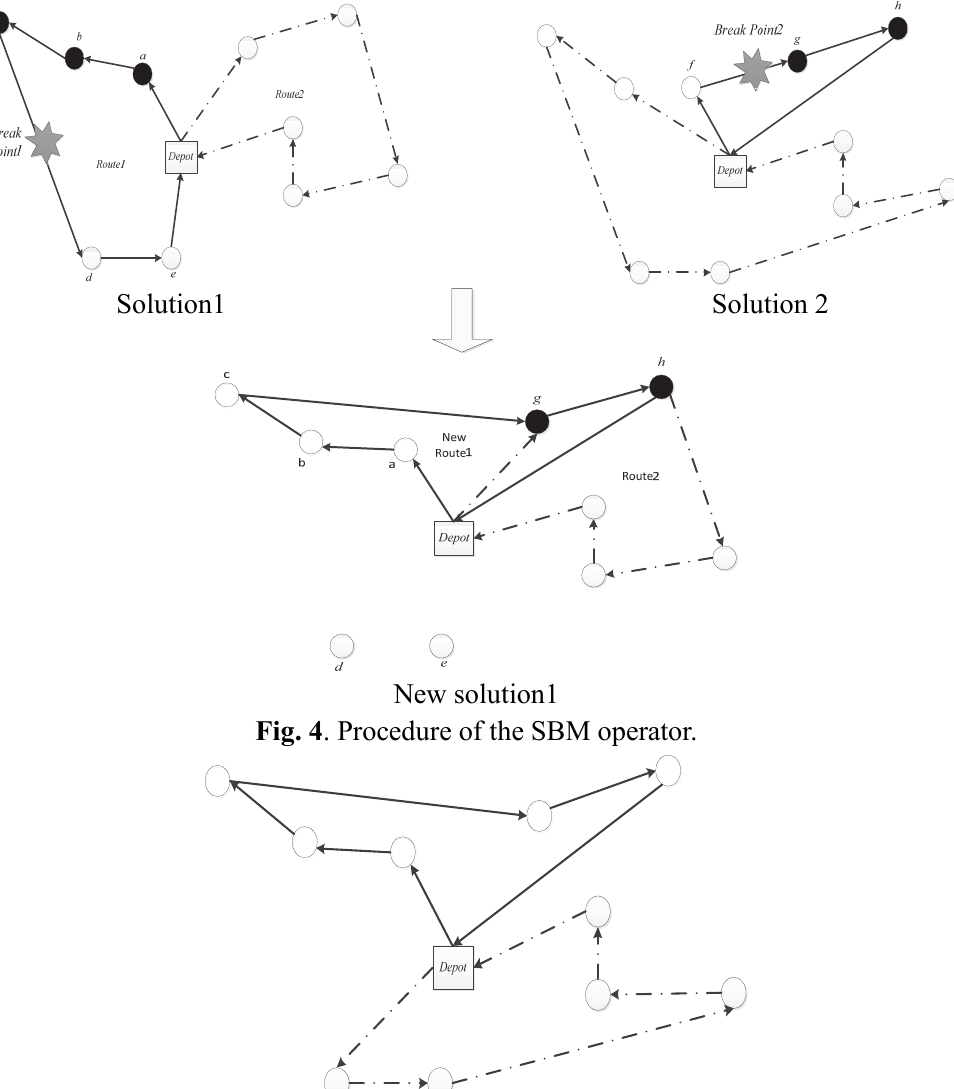
Fig. 4 . Procedure of the SBM operator.